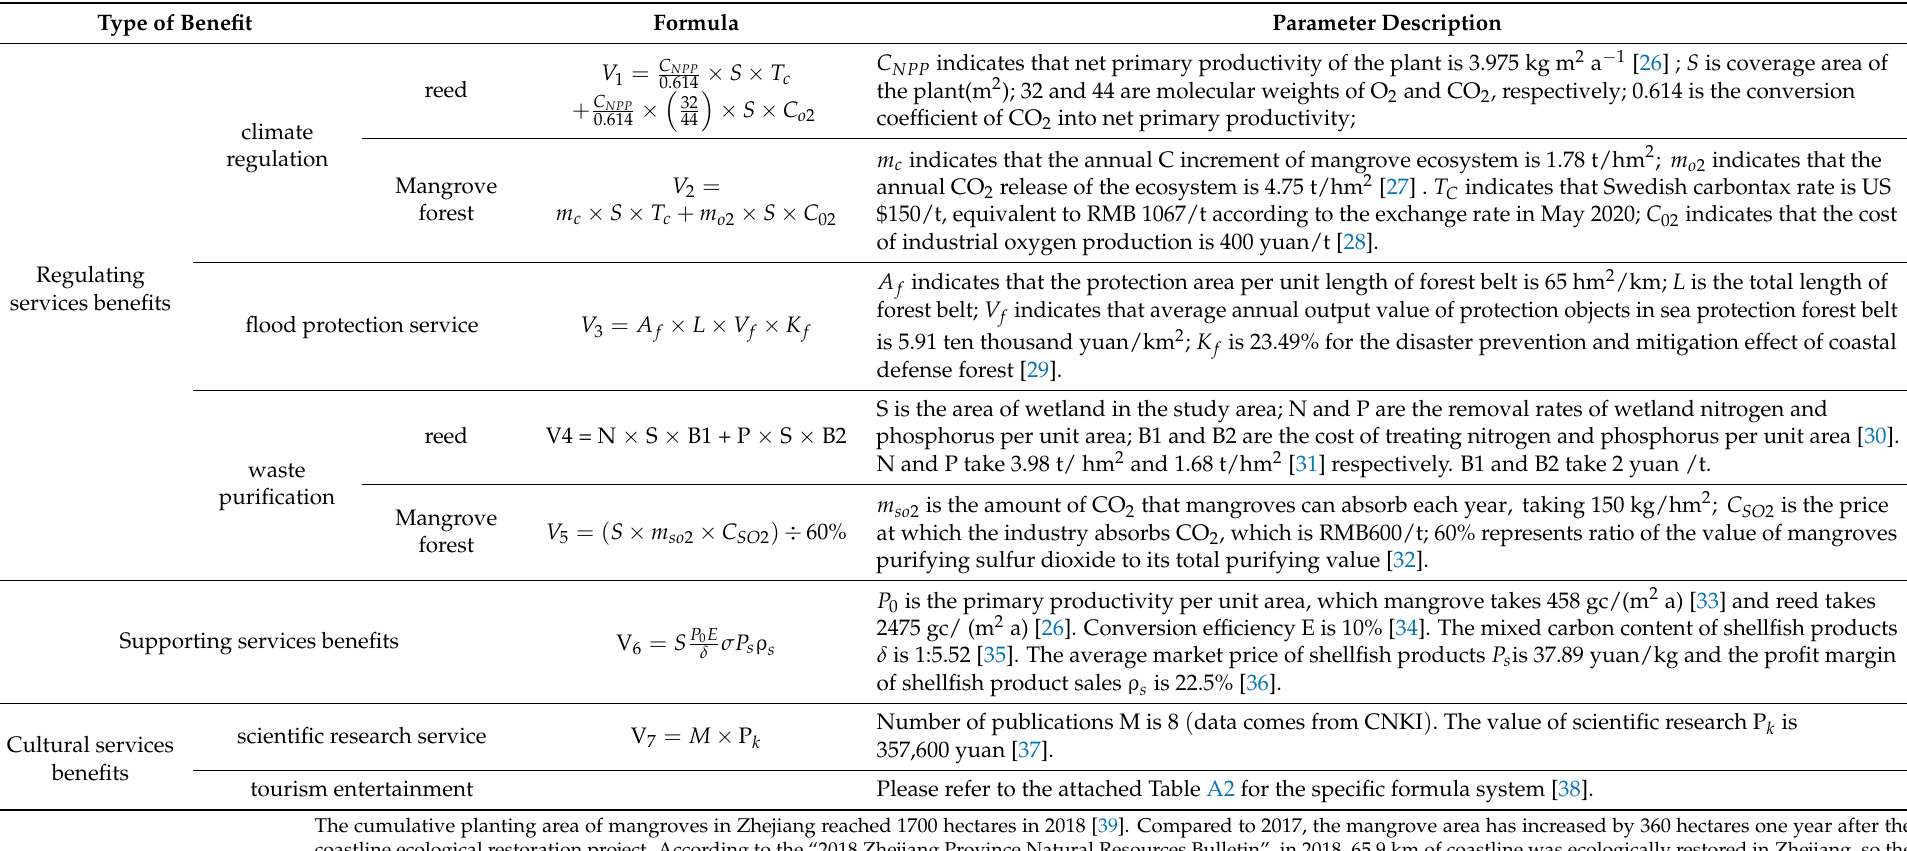
Table 3. Assessment system and formulas for calculating the value of ecosystem services (VES) in Zhejiang